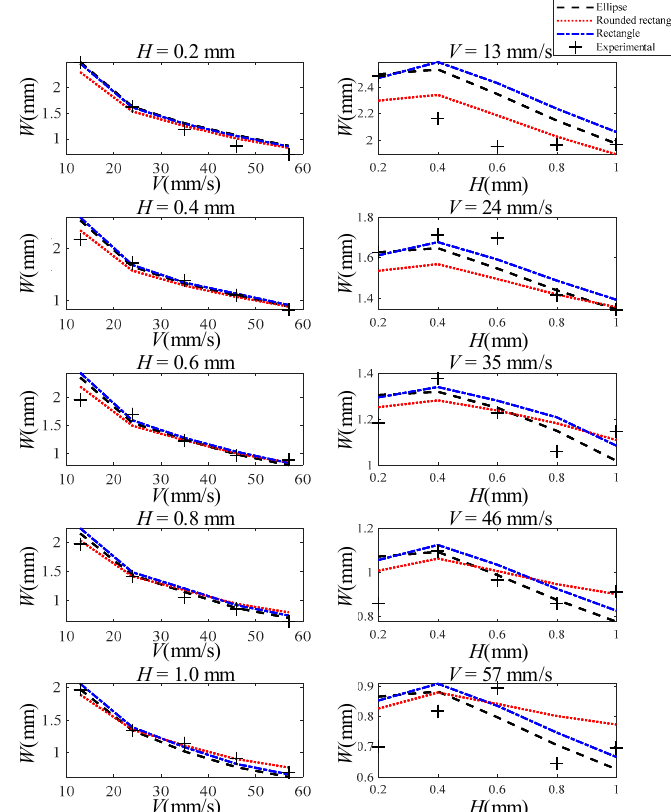
Figure 9. Experimental and theoretical results of strand width with different process parameters, where the black dashed line is the predicted strand width assuming an elliptical cross-section shape, the red dotted line is the predicted strand width assuming a rounded rectangular cross-section shape, the blue dash-dotted line is the predicted strand width assuming a rectangular cross-section shape, and the black plus sign is the experimentally measured value. The graphs in the first column show the relationship between strand width and moving speed of nozzle for different nozzle heights (0.2, 0.4, 0.6, 0.8, 1.0 mm); The second column of graphs shows the relationship between strand width and nozzle height for different moving speeds (13, 24, 35, 46, 57 mm/s).